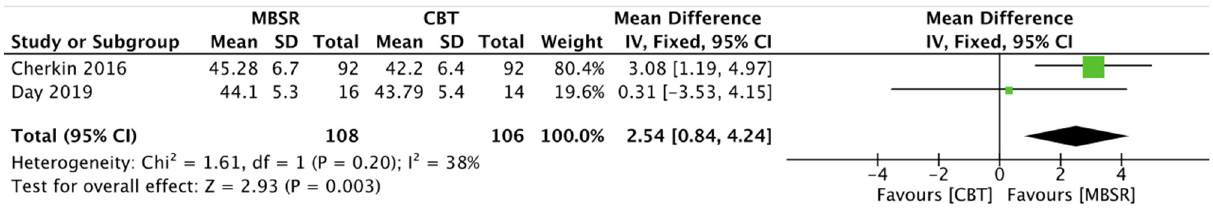
Figure 9. Quality of Life: MBSR versus CBT.